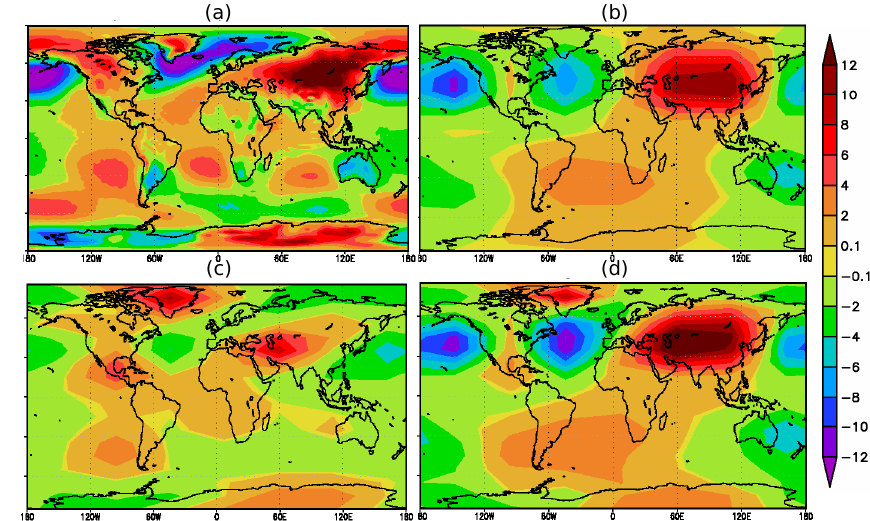
Fig. 1. Difference between sea-level pressure and its zonal mean in winter (DJF) for (a) NCEP reanalysis, (b) with only thermal parameteri- zation (TH), (c) with only orographic parameterization (ORO) and (d) for the sum of the two parameterizations (OTH) (hPa).